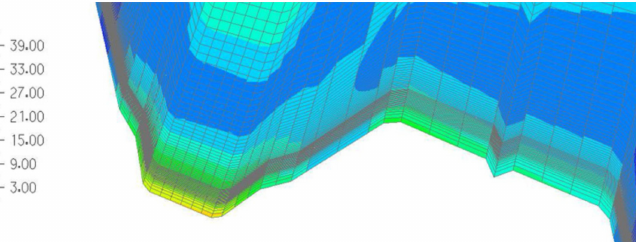
Figure 27. The map of the σ yy normal stresses acting orthogonally to the fold’s longitudinal axis, on the selected crosswise end of a shell fold.